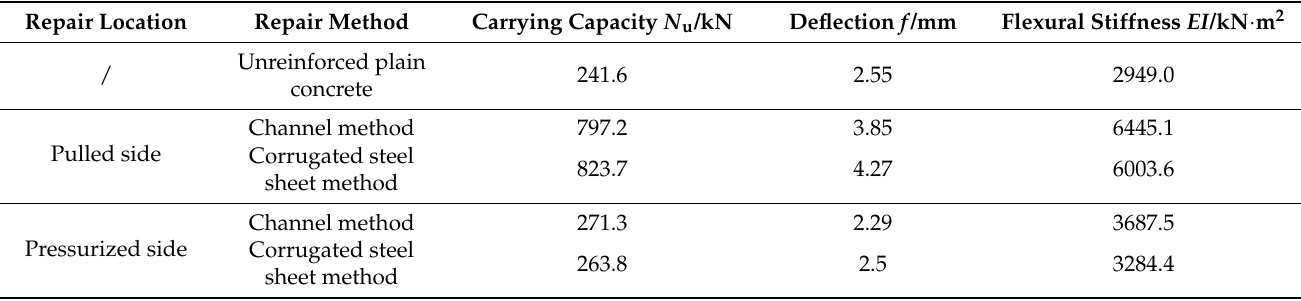
Table 3. Flexural stiffness of specimen.